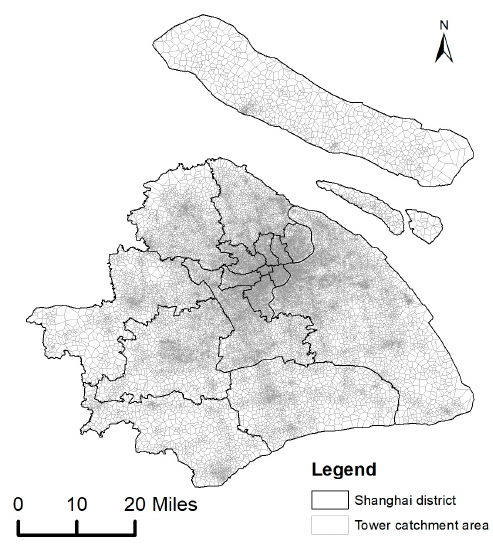
Int. J. Environ. Res. Public Health 2019 , 16 , x 10 of 20 Figure 6. Map of the study area. Figure 6. Map of the study area. Table 1. Instance of one individual’s trajectory data.